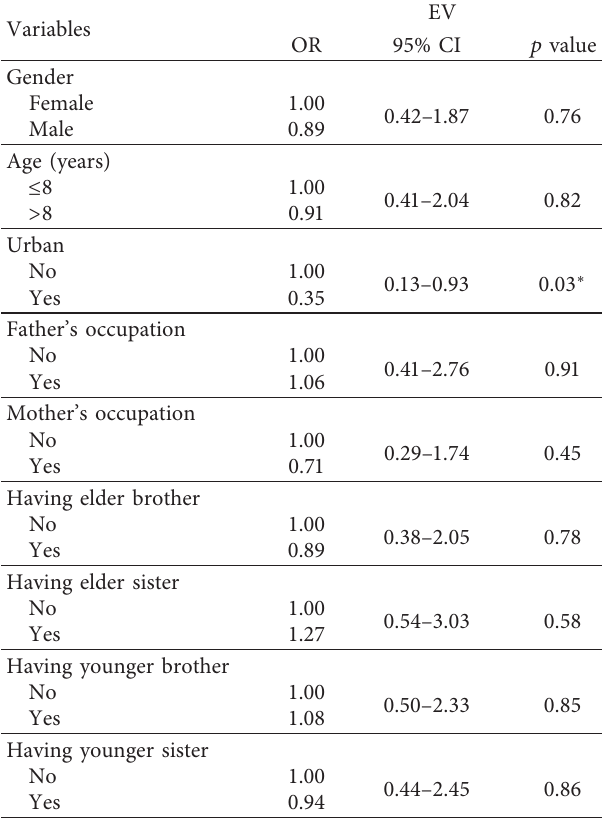
Table 3: Logistic regression analysis of risk factors associated with Enterobius vermicularis infection among primary schoolchildren in the Marshall Islands.